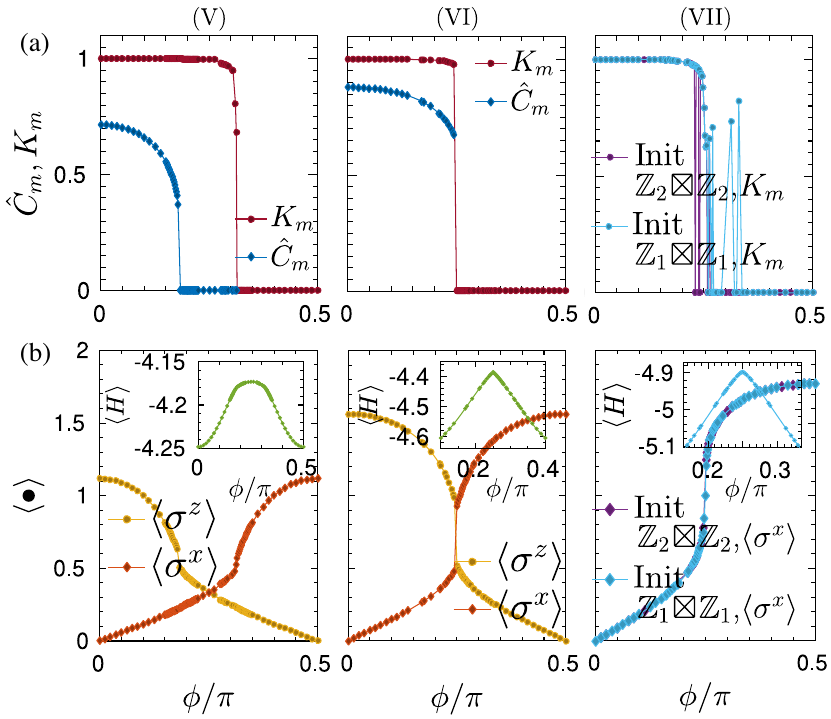
FIG. 9. Behavior for rotating field, lines V – VII, which move between two different condensation mechanisms of realizing the trivial phase. Each column corresponds to one of the lines V – VII. Top row (a): condensate and deconfinement fraction of magnetic fluxes. Bottom row (b): magnetization h σ and h σ and energy h H i (inset). Line V has two second-order phase transitions with a topological x i z i phase in between, line VI a first-order phase transition between the two inequivalent trivial phases, and line VII a crossover. For line VII, we rather show the deconfinement fraction, the x magnetization, and the energy for two different choices of initial conditions (following the notation of Ref. [35], Z 1 ⊠ Z 1 denotes the flux confined phase and Z 2 ⊠ Z 2 the flux condensed phase): We find that, while the physical properties converge independent of the initial configuration, the interpretation in terms of a charge or flux condensate becomes unstable around ϕ ≈ π = 4 , indicating a crossover regime where the interpretation of the physical phase in terms of the virtual symmetries breaks